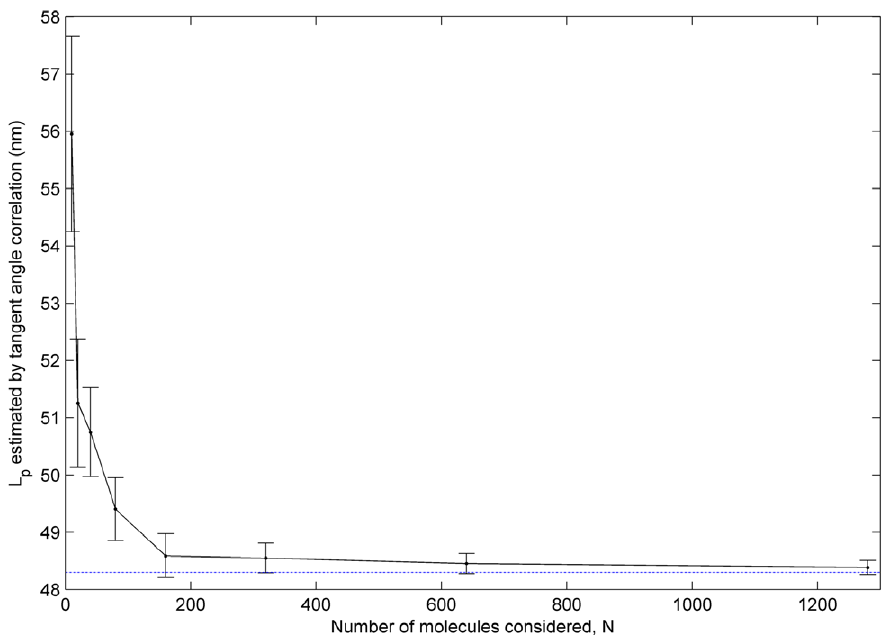
Figure 7. A sufficiently large population of a Tm molecules is required for reliable measurement of L p . L p was calculated for each of 200 subsets of N a Tm (N=10, 20, 40…) randomly selected from a total of 1852 molecules. The mean L p is plotted against N. A consistent overestimation of L p up to 8 nm was observed for small N ( , 80–160). This overestimation can be attributed to the biased distribution of contour shapes, where highly bent configurations of the molecule are relatively rare. In case of small N, therefore, the highly bent configurations are under- or un-sampled, which leads to overestimation of L p based on a biased population of relatively straight molecules.